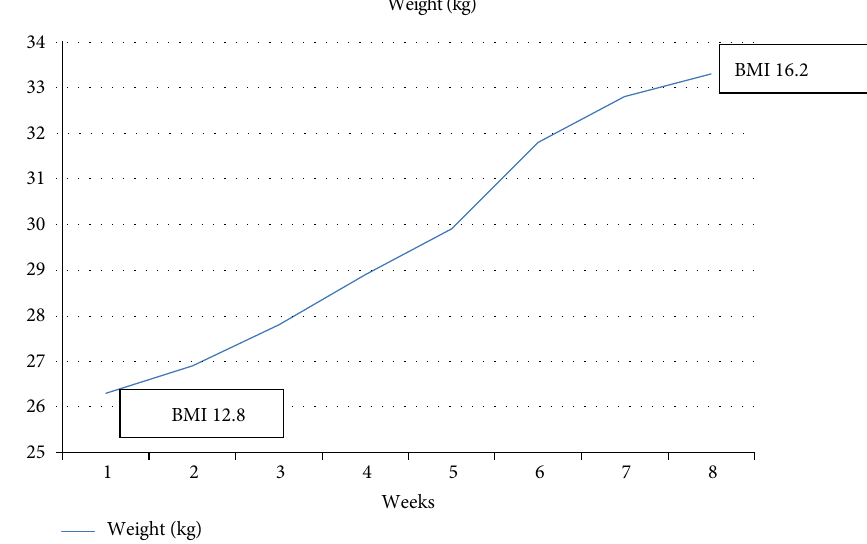
Figure 1: Progress of weight over the course of